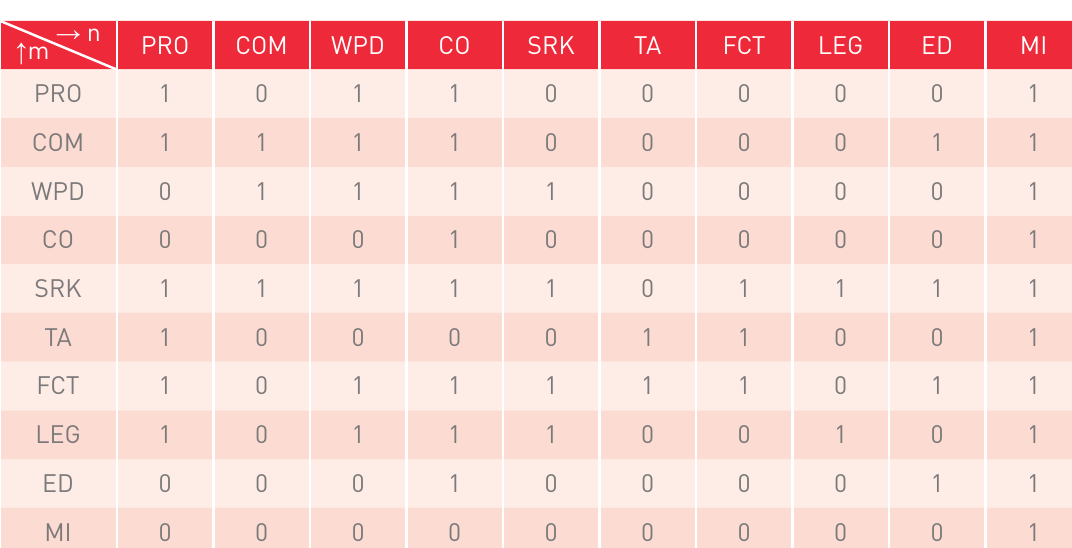
Initial Reachability Matrix